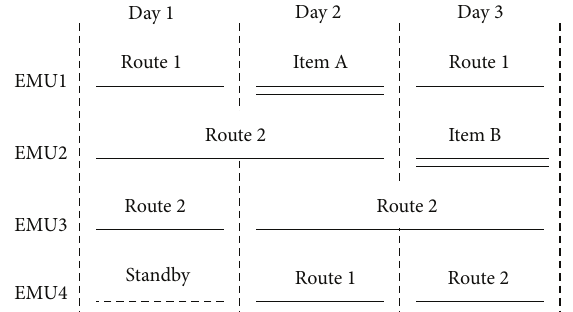
Figure 2: An example of motor train set assignment and mainte- nance